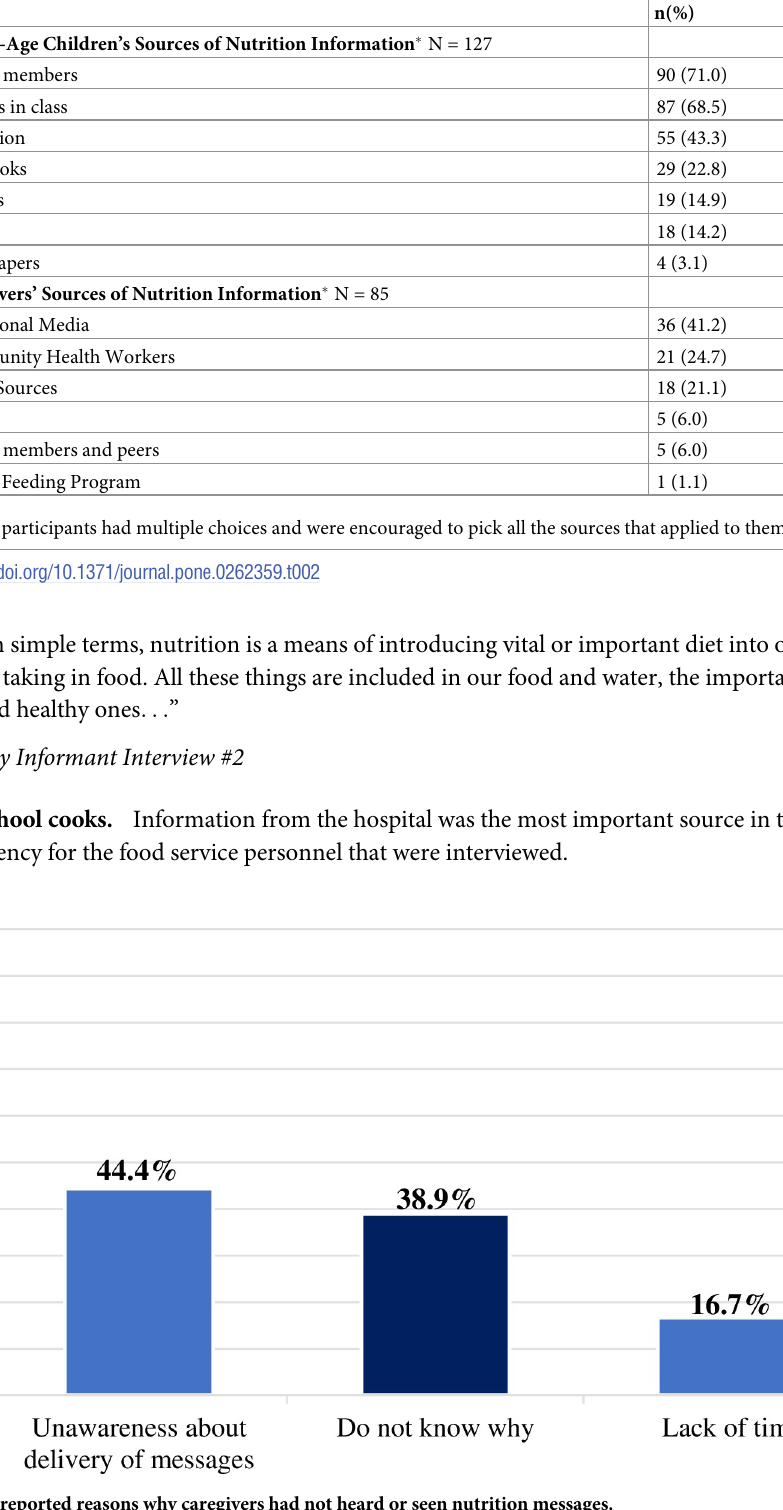
Table 2. Sources of nutrition information of parents and children.